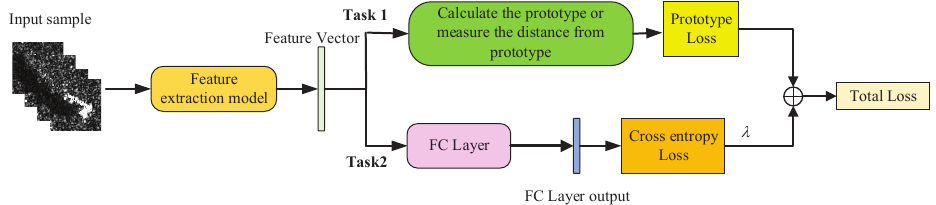
Figure 3. Multi-task learning